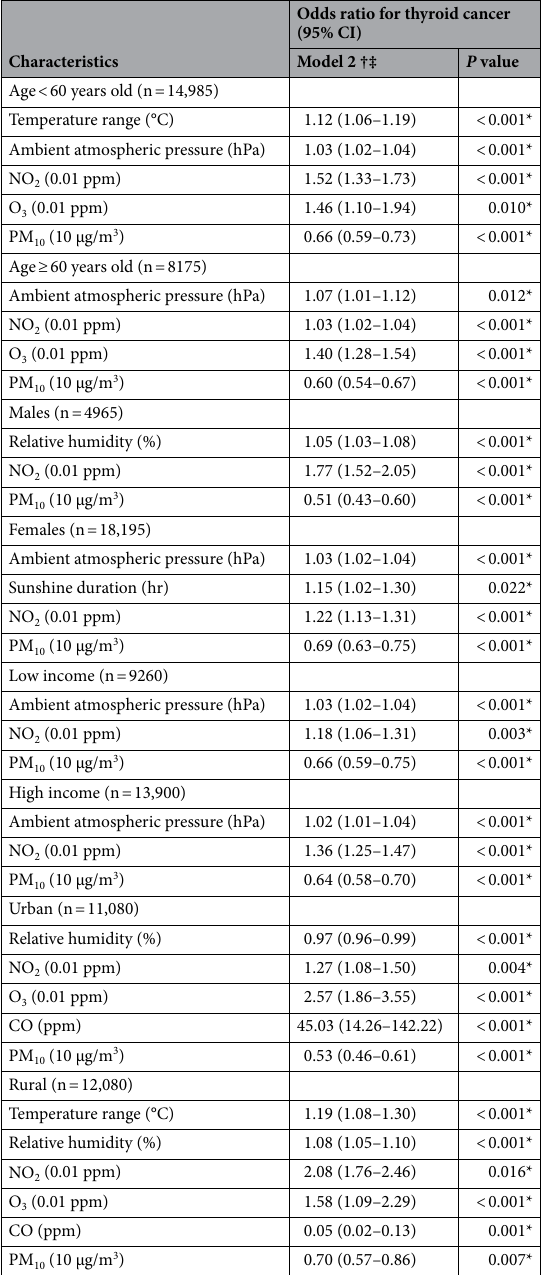
Table 3. Subgroup analyses of crude and adjusted odd ratios (95% confidence interval, CI) of meteorological conditions and air pollution parameters (mean of 3 years [1095 days] before index date) for thyroid cancer according to age, sex, income, and region of residence. CCI Charlson comorbidity index; DBP diastolic blood pressure; SBP, systolic blood pressure. *Conditional logistic regression model, significance at P < 0.05. † Stratified model for age group, sex, income, and region of residence. ‡ Model 2 was adjusted for total cholesterol, SBP, DBP, fasting blood glucose, obesity, smoking status, alcohol consumption, CCI score, temperature range, relative humidity, ambient atmospheric pressure, sunshine duration, SO 2 , NO 2 , O 3 , CO, and PM 10 using the forward selection